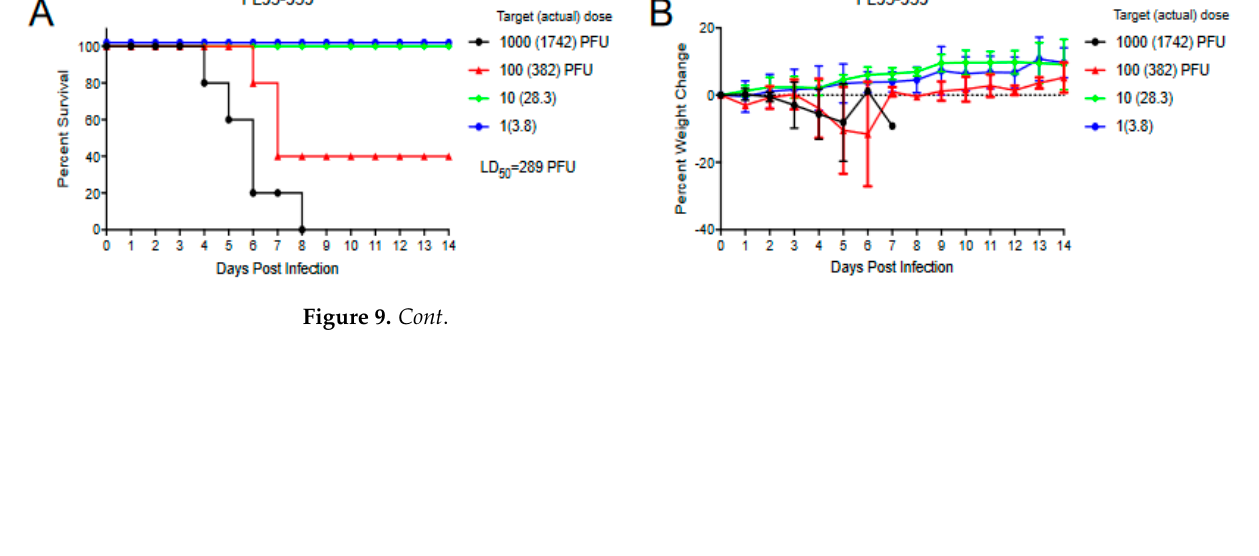
Figure 9. Aerosol LD 50 mortality curves ( A , C ) and weight loss data ( B , D ) for 4–week–old CD–1 mice infected with each indicated virus. Values with question marks are estimates of aerosol dose based on virus dilution. Aerosol LD 50 infections included 5 or 10 mice per group and were replicated with at least four dilutions per experiment. Error bars are standard deviations. With WEEV, we compared the McMillan clone with either Fleming or this virus with lysine changed to glutamic acid at E2 84 or this mutation and valine changed to methio- nine at E2 83 (K84D, V83M) (Figure 10). After sc. infection, McMillan and Fleming survival times were not significantly different ( p > 0.436) and neither virus was significantly differ- ent from the single glutamic acid 84 mutant (K84D, p = 0.306 and p = 0.369, respectively) (Figure 10A). However, the double mutant was significantly attenuated versus Fleming ( p = 0.025) (Figure 10A) and slightly but not significantly different from McMillan ( p = 0.126). Interestingly, the McMillan aerosol LD 50 was significantly lower than that of Flem- ing (0.9 versus 58.8 PFU, p < 0.001) (Figure 11). The E2 mutant WEEVs were not tested in aerosol infections due to attenuation observed after sc. infection.